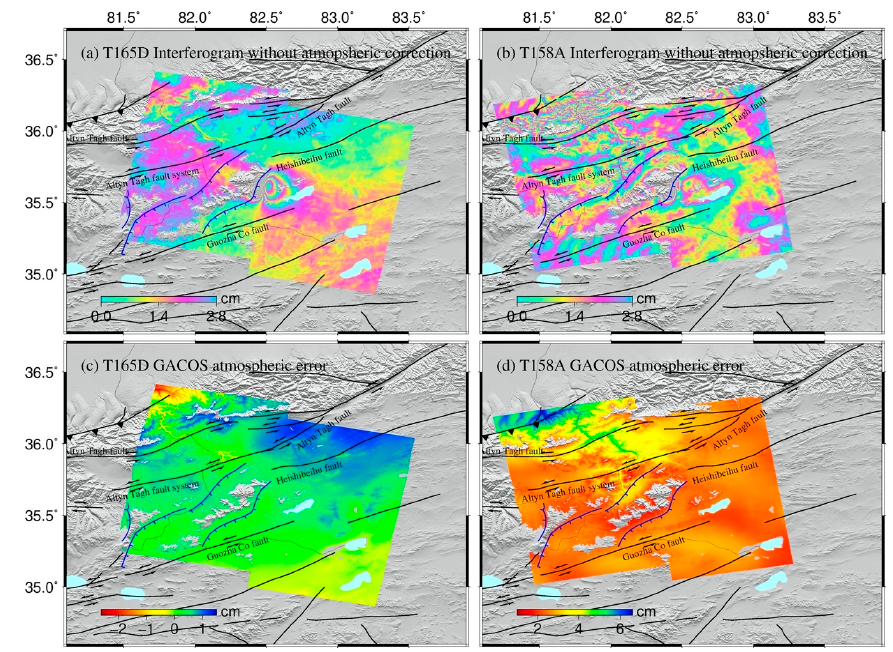
Figure 3. Interferograms and their atmospheric errors from Generic Atmospheric Correction Online Service (GACOS) model. ( a,b ) Original interferograms for T165D, T158A. ( c,d ) Atmospheric phase errors for relative interferograms.